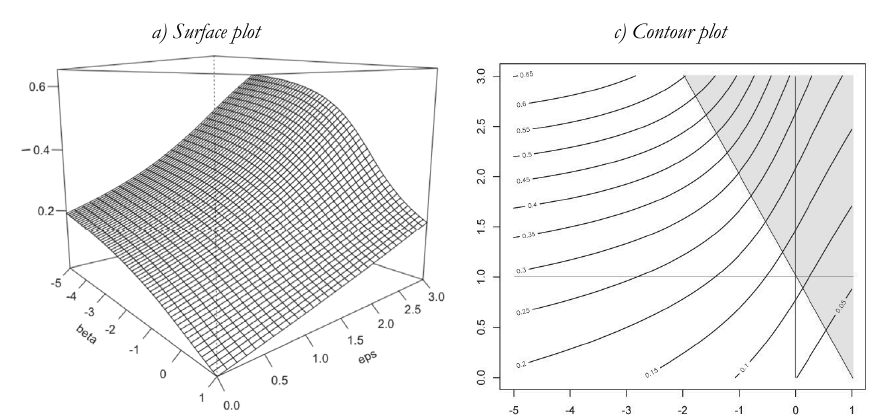
Figure 1 – Multidimensional inequality as a function of  and  parameters Note: the parameter combinations for which the multidimensional inequality index in (19) satisfies the CIM axiom are high- lighted in grey. Source: authors’ elaboration on 2008 IT-SILC data.